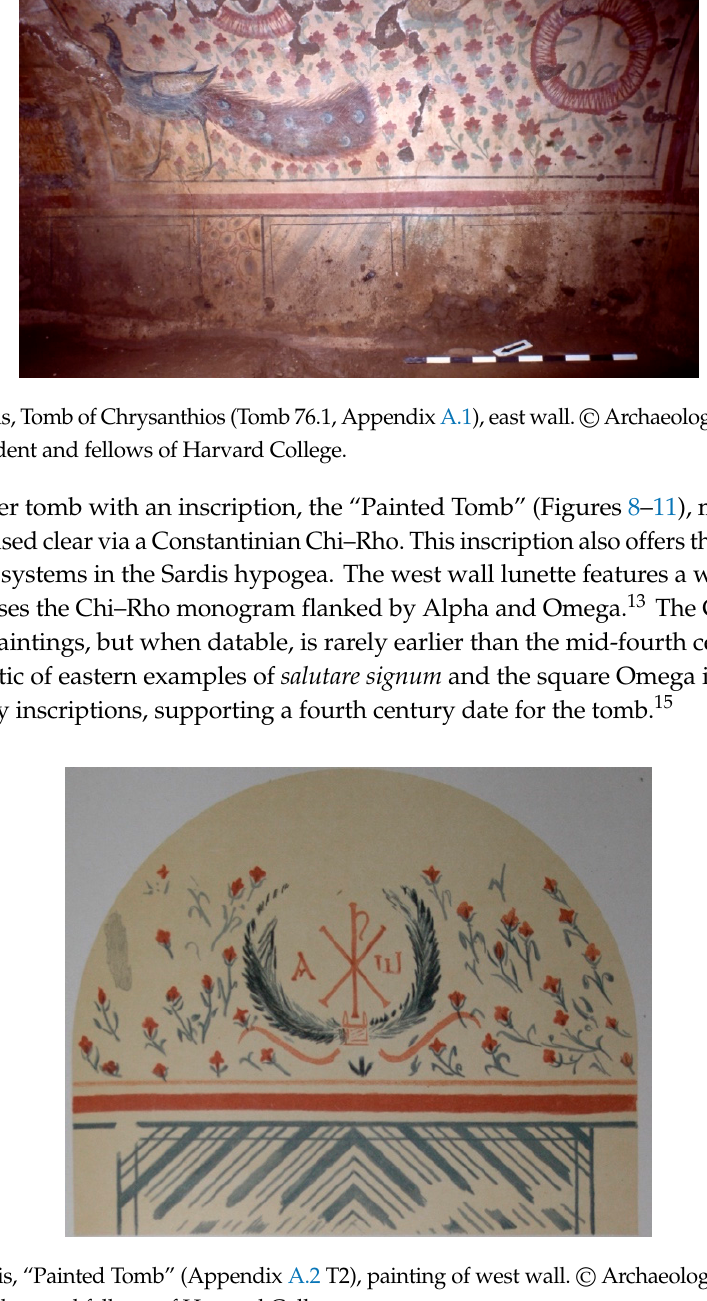
Figure 6. Sardis, Tomb of Chrysanthios (Tomb 76.1, Appendix A.1), south wall. © Archaeological